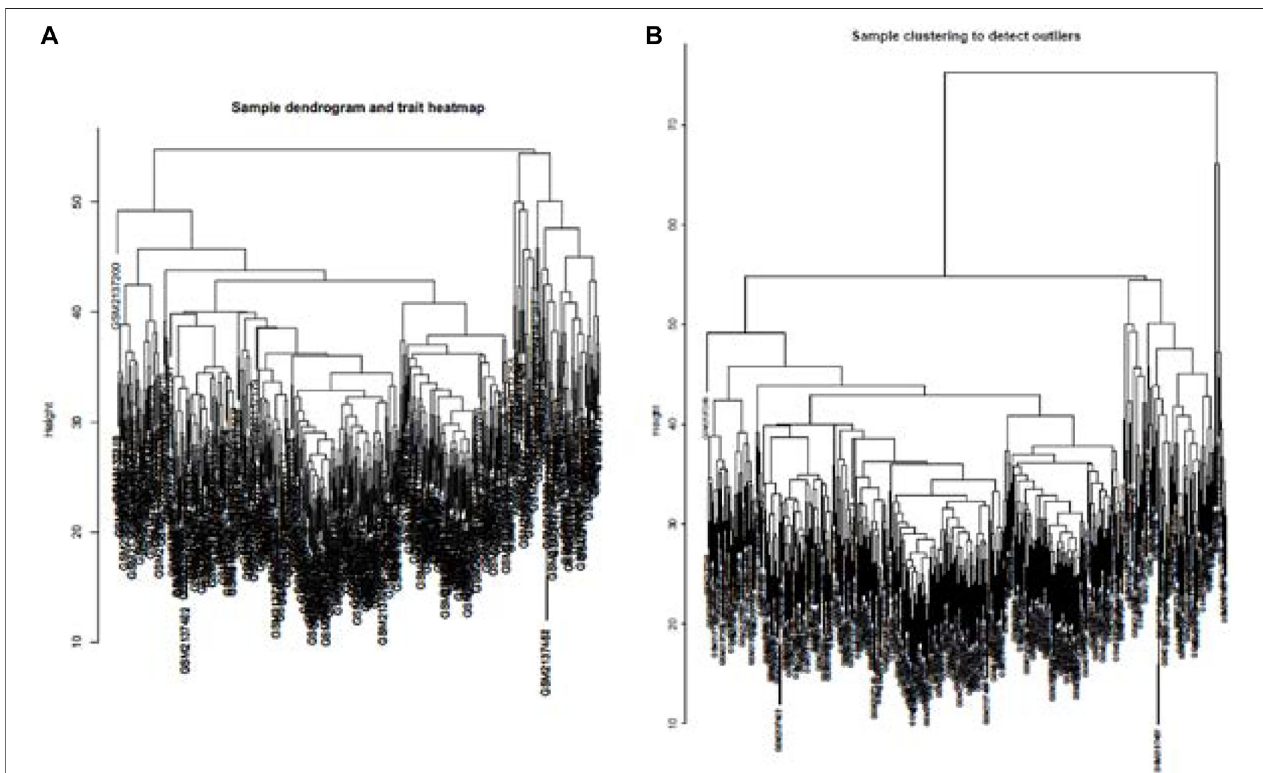
FIGURE 1 | lustering all the samples in the input sets (A) . Height of data > 55 cannot be well clustered with other data. Therefore, as outliers, data with height > 55 were removed. Dendrogram of residual samples was constructed as shown (B) .